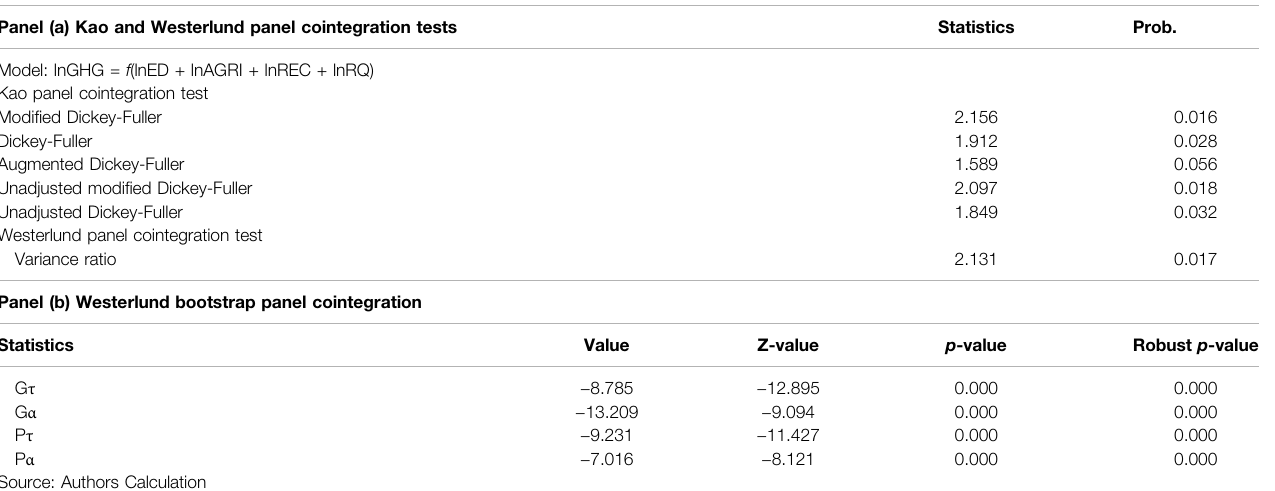
TABLE 4 | Panel cointegration tests for Asian